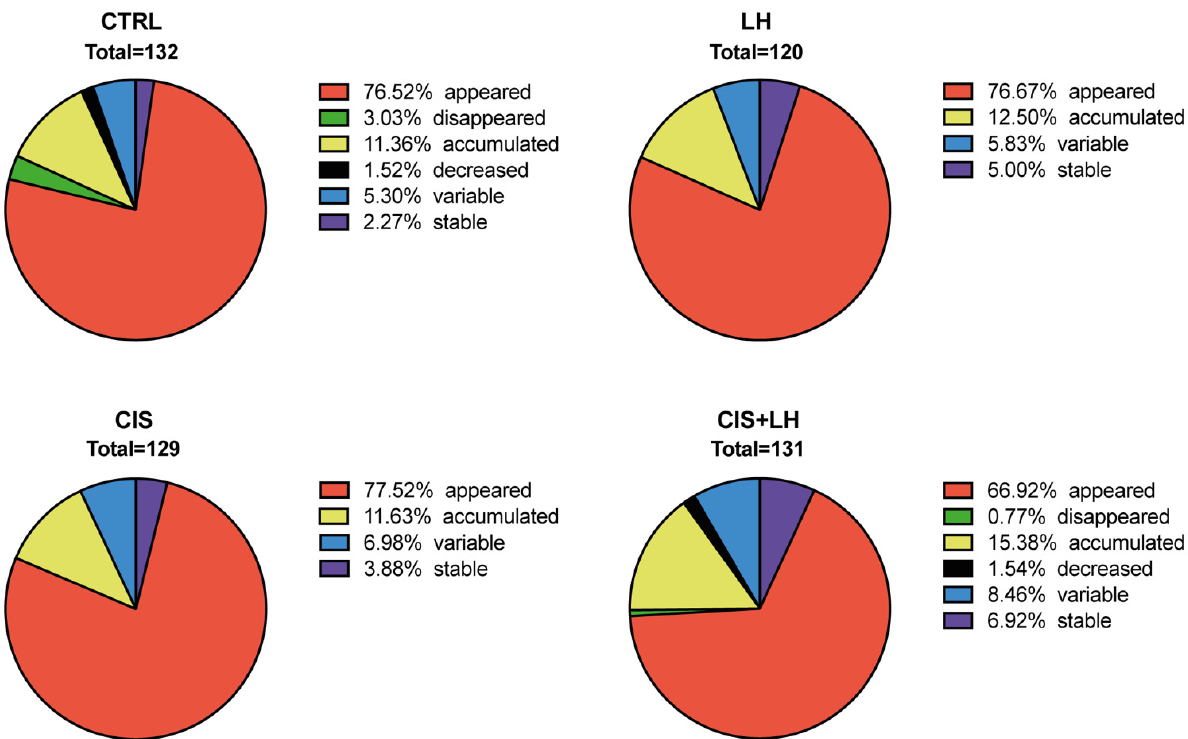
Figure 3. Metabolites’ percentage trend during culture time in CTRL, LH, CIS, and CIS + LH. Ap- peared: proteins that were not expressed at 2 h but appeared during culture time (red). Disappeared: proteins whose expression disappeared during the culture period (green). Accumulated: proteins already expressed at 2 h time point and whose expression increased during the culture time (yellow). Decreased: proteins expressed at 2 h of culture and whose expression decreased during the 24 h of analysis (black). Variable: proteins with a variable expression mode over time (blue). Stable: proteins whose expression did not change during the period of culture analyzed (purple).